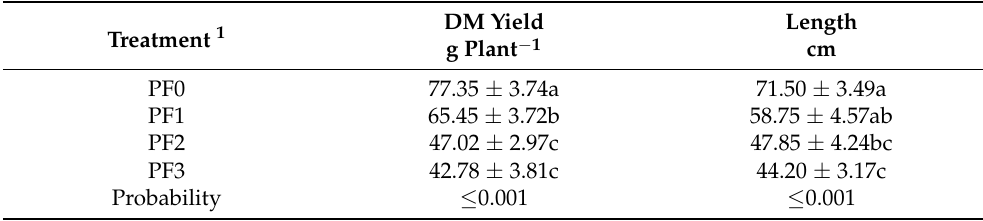
Table 2. Root DM yield and root length of S. sesban as affected by pruning